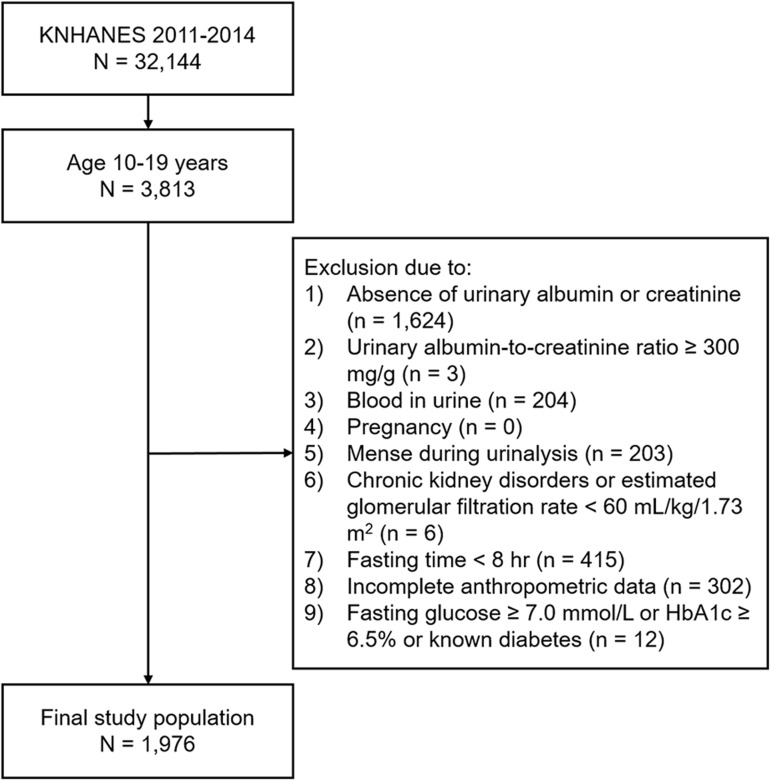
Flow chart of eligible study population.